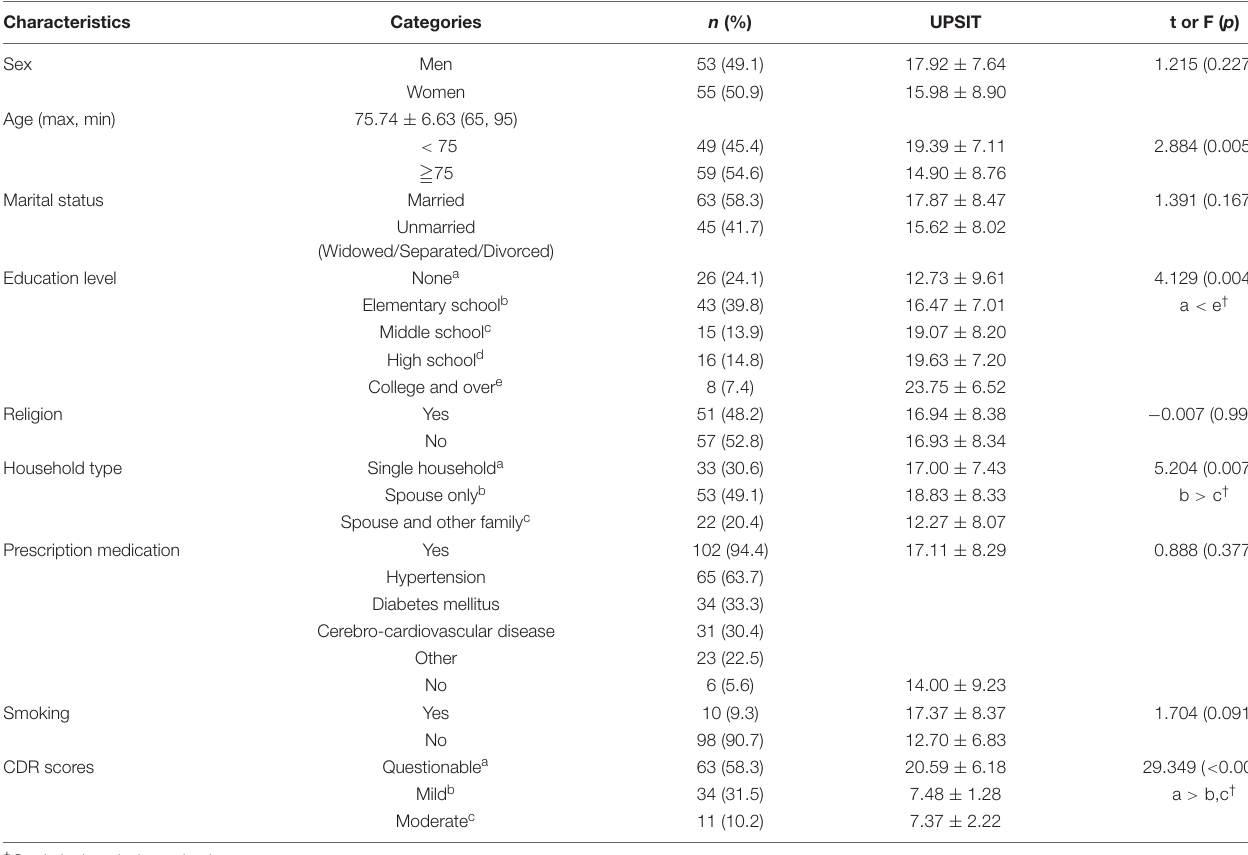
TABLE 1 | General characteristics of participants and differences in UPSIT scores ( N = 108).